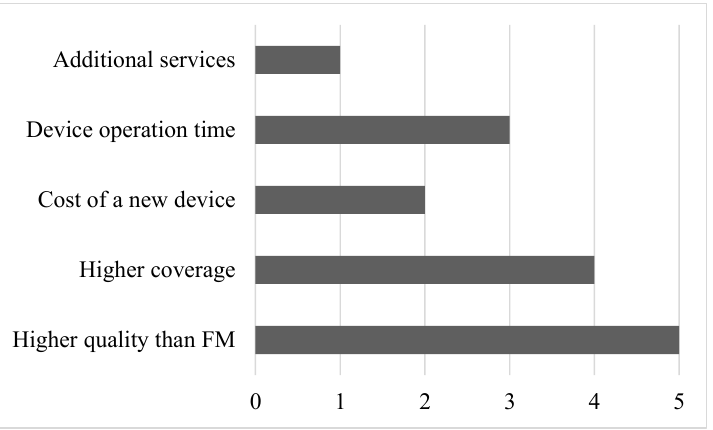
Figure 3. Factors necessary for a successful switchover from analog FM to digital DAB+ radio.